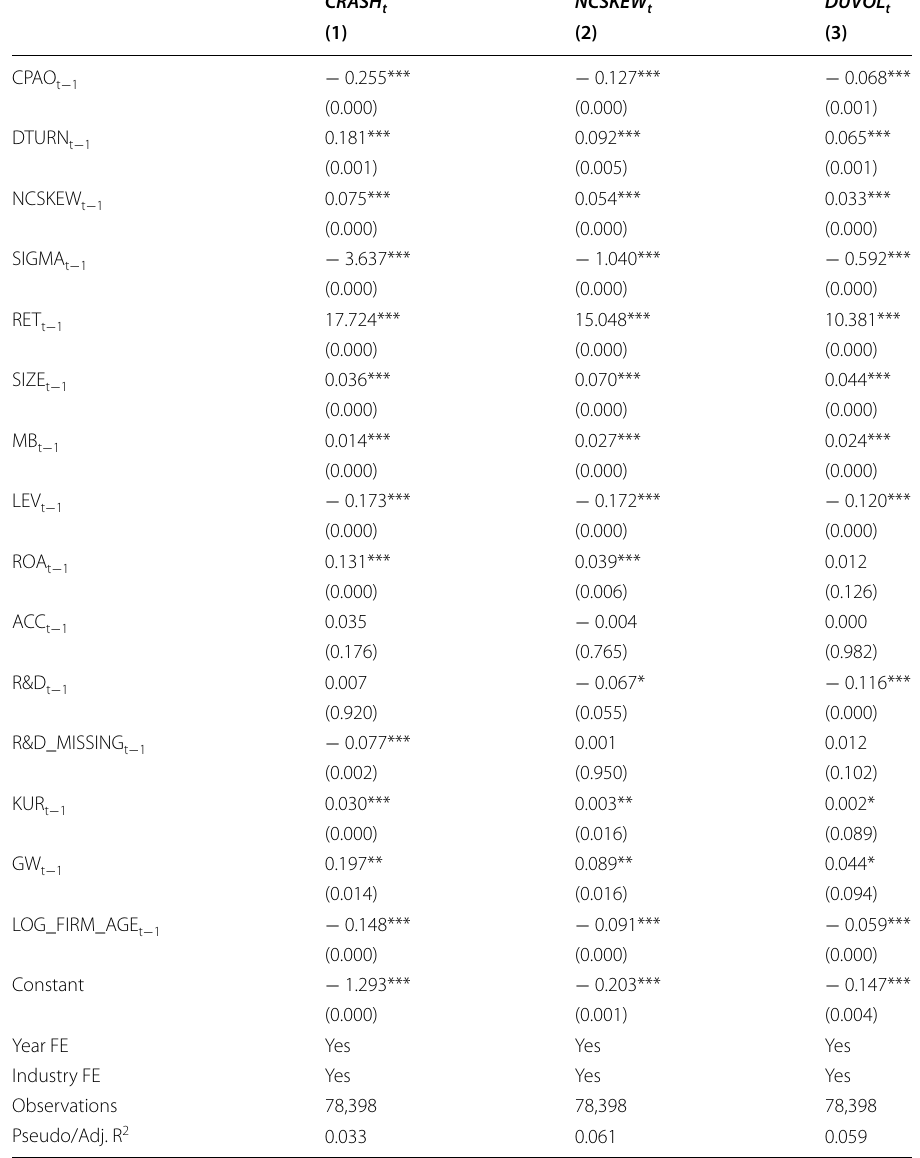
Table 6 Excluding financial crisis